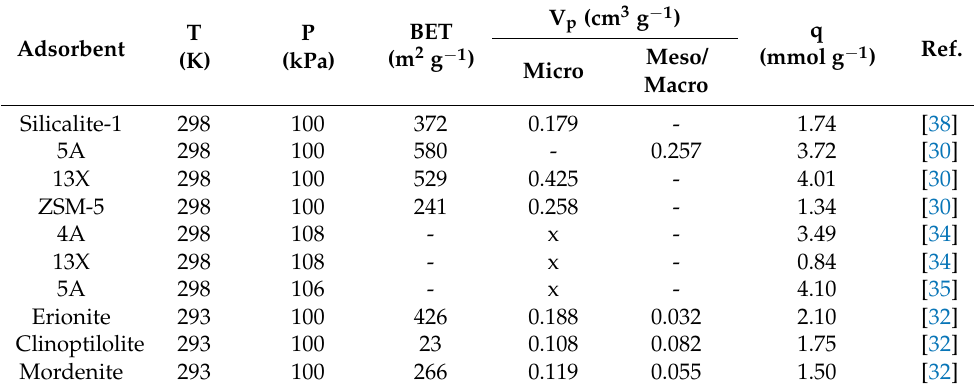
Table 4. Zeolites based materials in N 2 O adsorption studies.